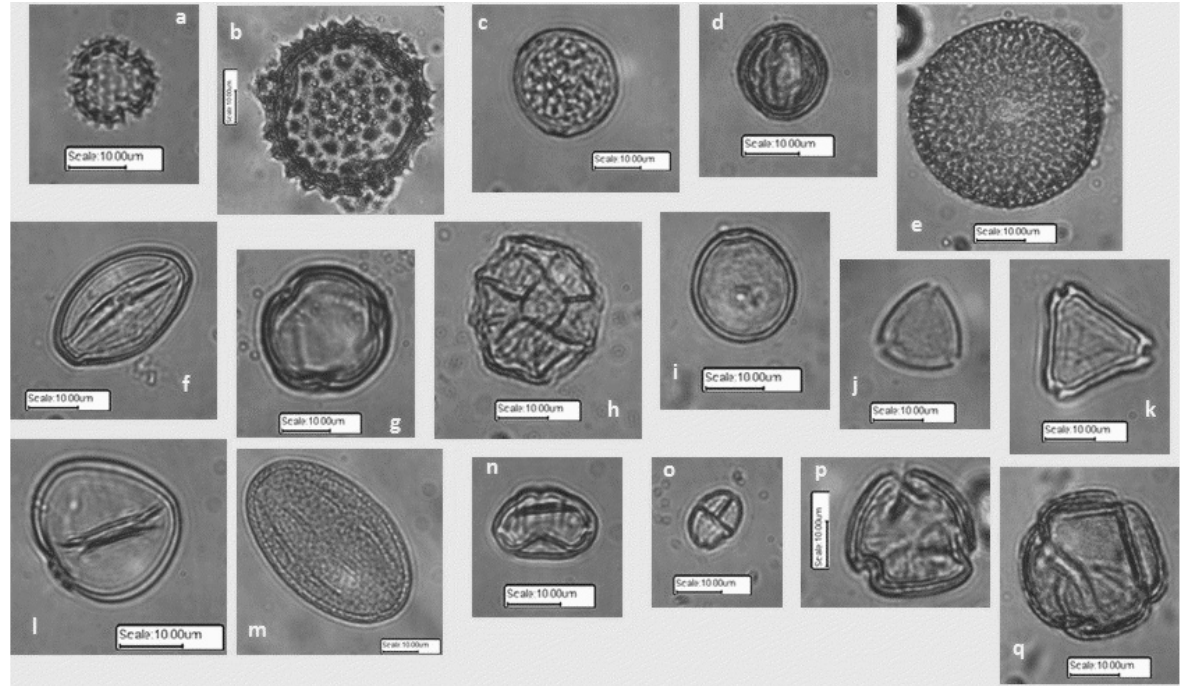
Figure 2 - Pollen grains found in bee pollen collected in different seasons: ( a ) Asteraceae sp.1; ( b ) Asteraceae sp.2; ( c )